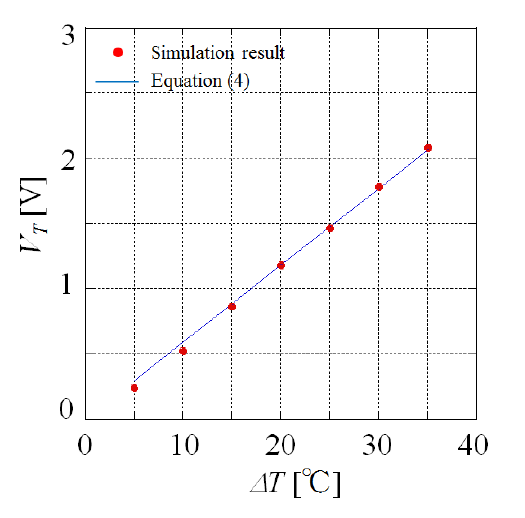
and p relative to approximation formulas. ( a )  T - V T